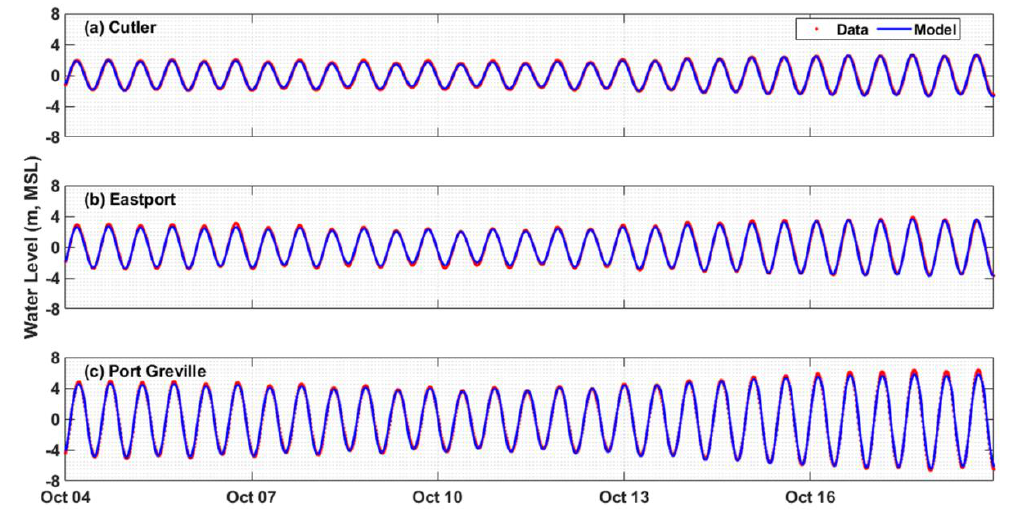
Figure 4. Comparison of the modeled and observed water levels at ( a ) Cutler, ME; ( b ) Eastport, ME; and ( c ) Port Greville, NS. Station locations are shown in Figures 1 and 2. Table 2. Error statistics of water-level predictions for model calibration.